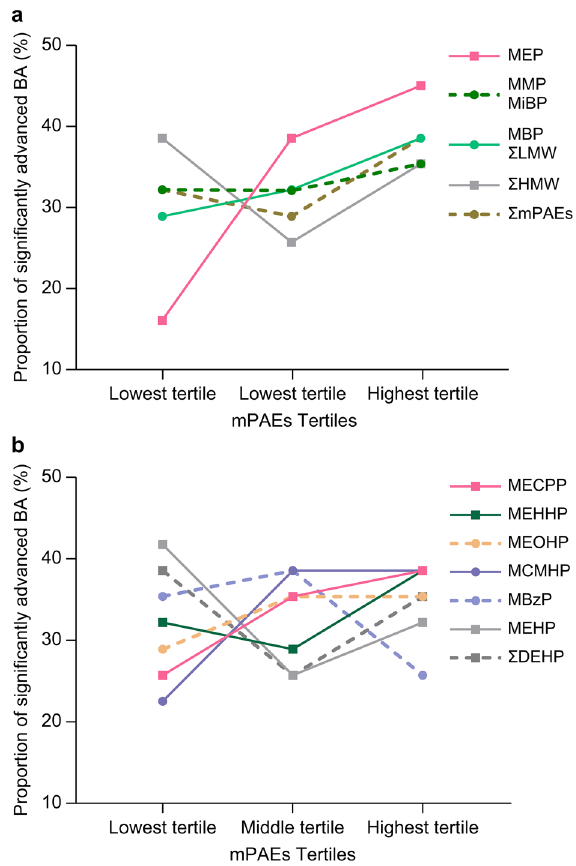
Figure 3. The proportion of significantly advanced bone age (BA) between the tertiles of the ( a ) low molecular weight mPAEs, ΣLMW, ΣHMW, and ΣmPAEs; and ( b ) high molecular weight mPAEs and ΣDEHP groups. The proportion of significantly advanced BA in the highest MEP tertile was statistically higher than that in the lowest MEP tertile ( P < 0.05). ΣDEHP: sum of the creatinine-corrected concentrations of MCMHP, MEHP, MEOHP, MEHHP, and MECPP. ΣLMW: sum of the creatinine-corrected concentrations of MBP, MMP, MiBP, and MEP. ΣHMW: sum of the creatinine-corrected concentrations of ΣDEHP and MBzP. ΣmPAEs: sum of the creatinine- corrected concentrations of all of the